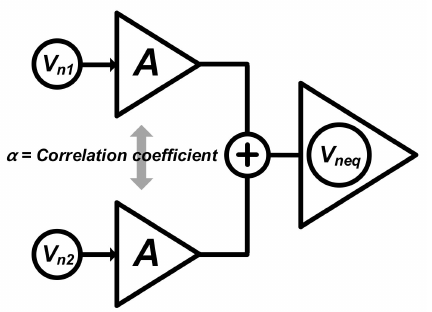
Figure 4. Diagram of the noise voltage summation of the amplifiers in the dual